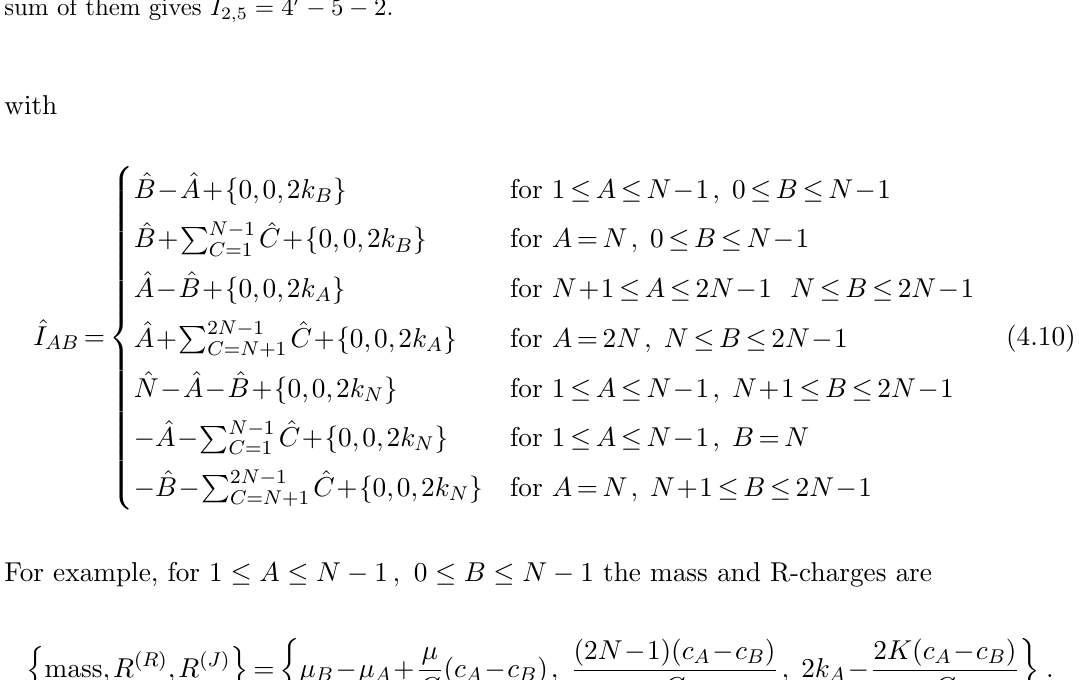
corresponding box. The dashed orange arrows represent the value subtracted by the SU( N ) 2 gauge transformation needed in order to satisfy (4.6). At the end, ^ I ab is given by the sum of the ^ I s that appear on the tail of the arrows crossing the corresponding block. Here ^ I 0 = ^ I + f 0 ; 0 ; 2 k I g except for diagonal elements for which ^ I 0 = ^ I . For example, there are 3 arrows crossing the box q 2 ; 5 .